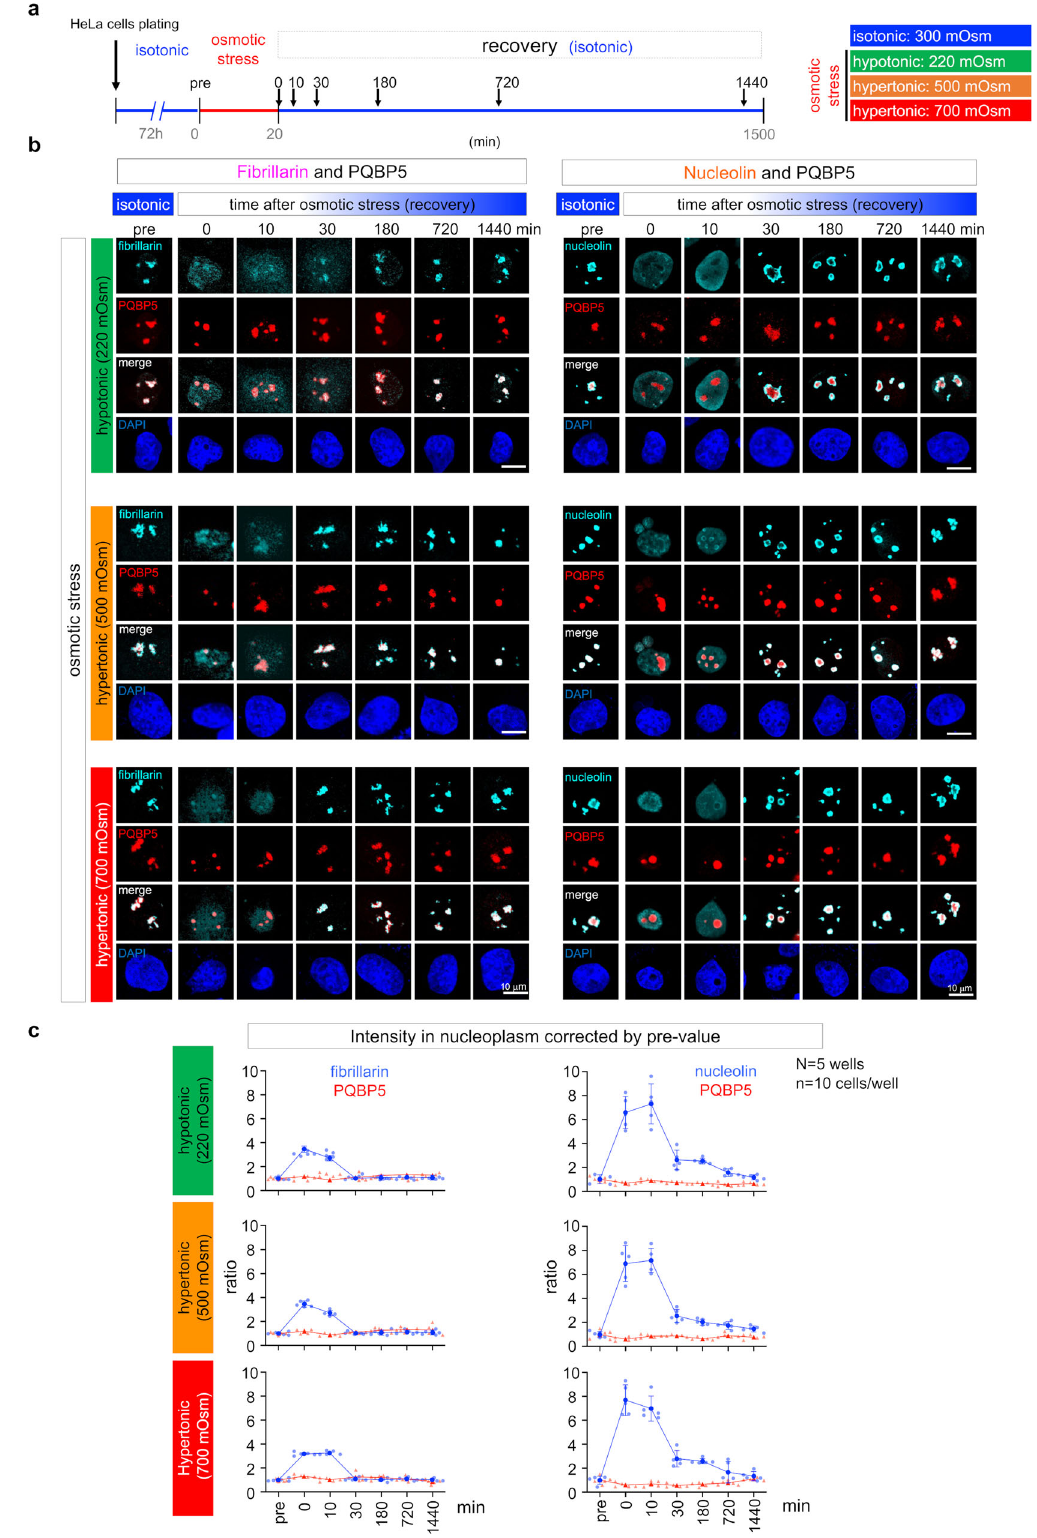
Fig. 3 | PQBP5 anchors the nucleolus under osmotic stress conditions. a Experimental protocol for the induction of osmotic stress. b Changes in the nucleolar distribution of nucleolar proteins during and after osmotic stress, as shown by the relationships of PQBP5 with fi brillarin and nucleolin in a single cell. HeLa cells subjected to three types of osmotic stress showed dispersion of fi bril- larin and nucleolin, but retention of PQBP5, in the nucleolus. During the recovery